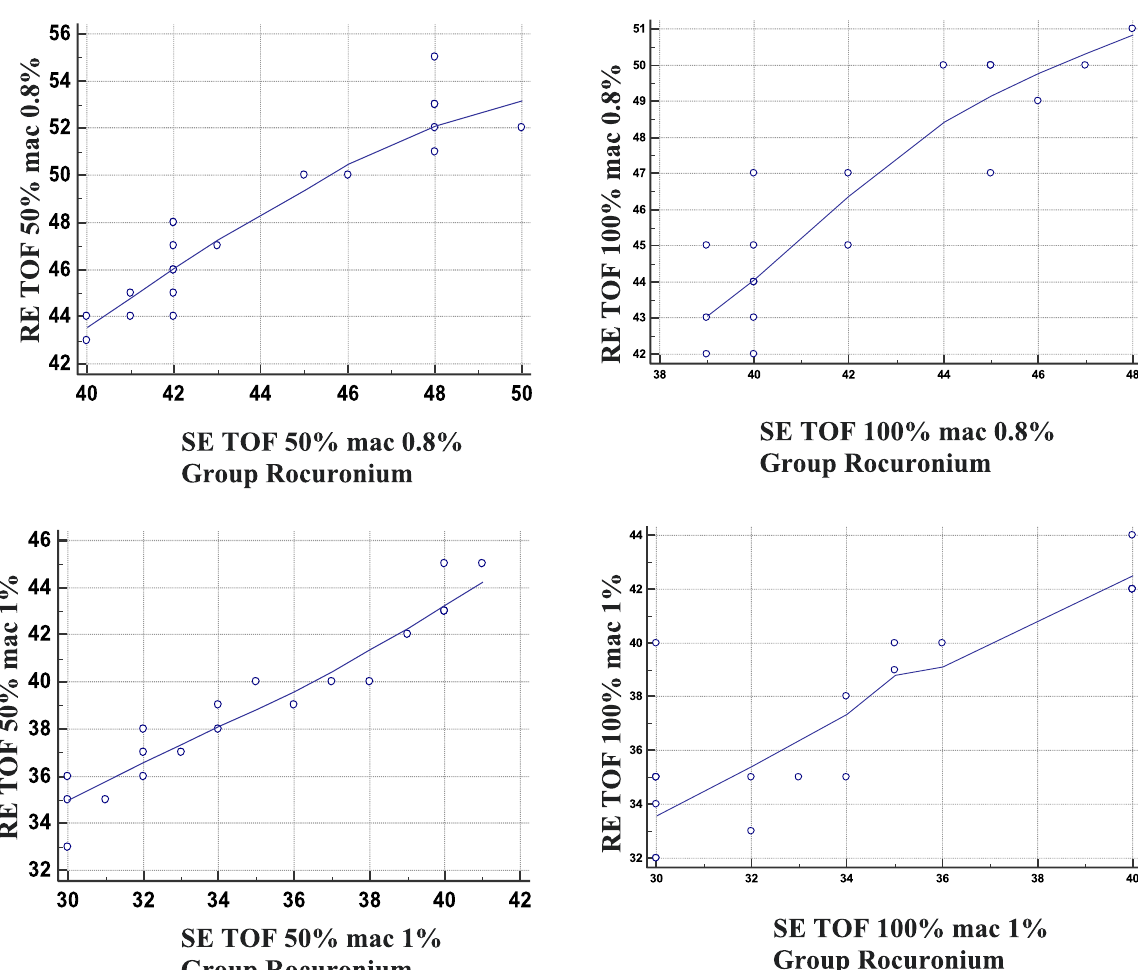
Fig. 3 Correlations between RE and SE at MAC 0.8% and 1% with TOF 50% and 100% of rocuronium group